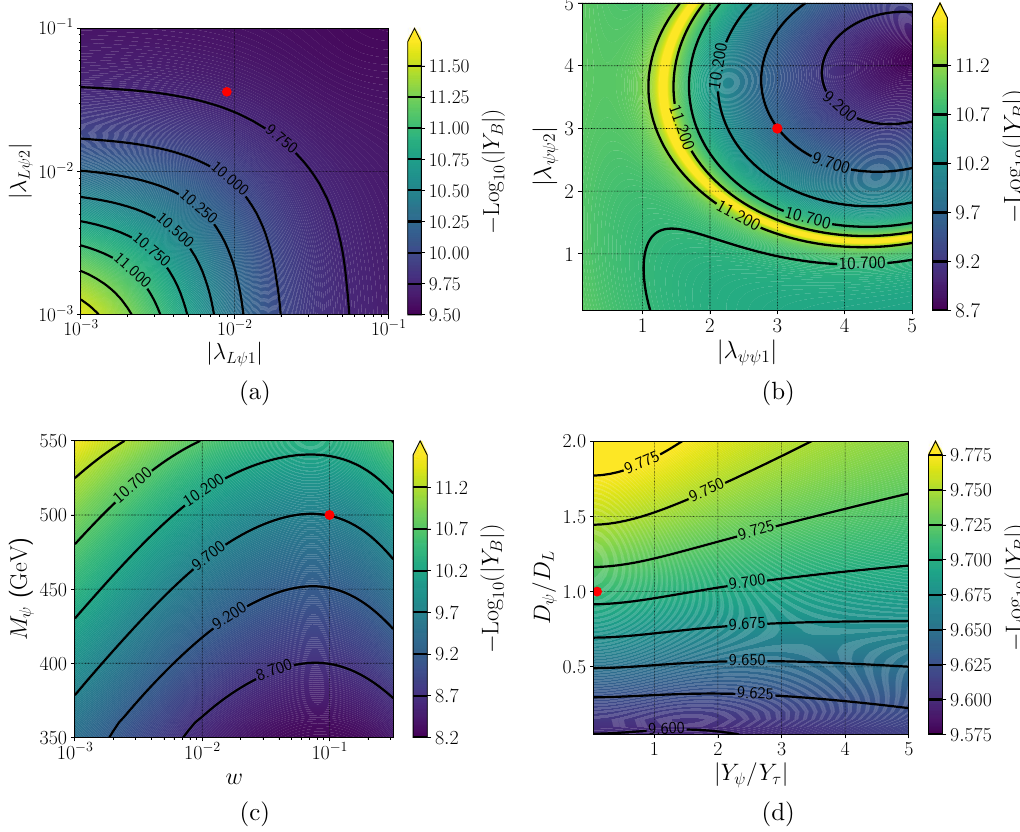
Figure 8. Contour plots showing the variation in the generated asymmetry as some of benchmark A ’s parameters are varied, with the original benchmark values indicated by a red point. Y τ and D L are held constant and used as reference values for the axes. The colour-mapping is different for each subplot. Darker colours indicate more asymmetry, brighter colours indicate